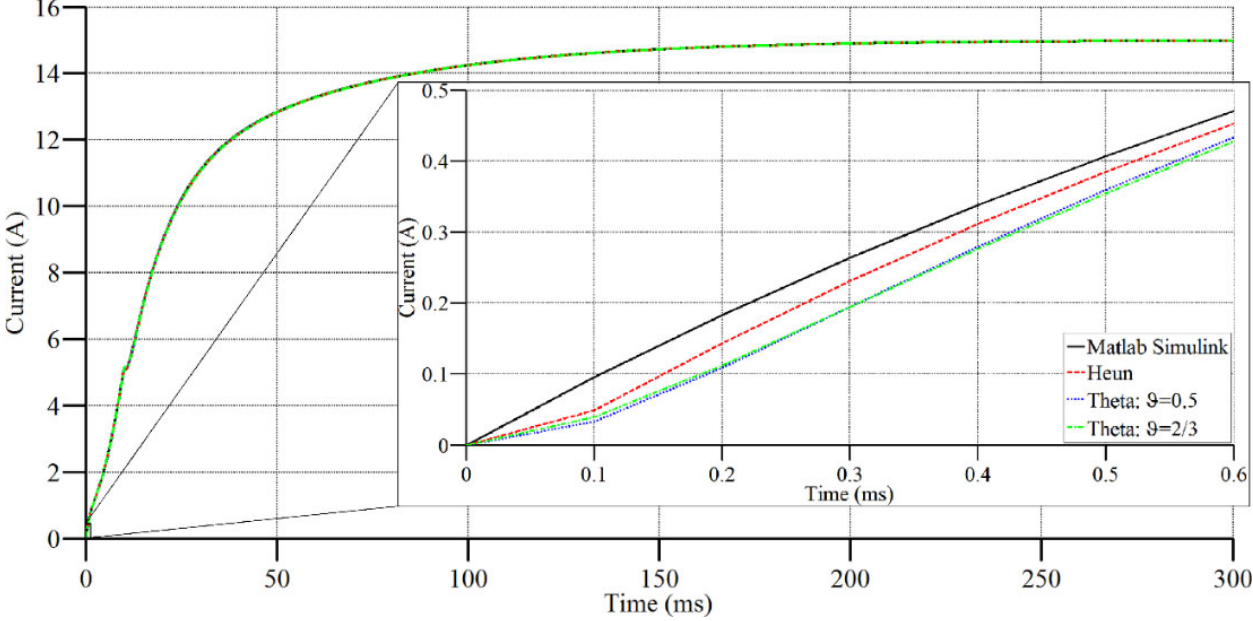
Figure 4. First branch current during the 0–0.6 ms time interval.